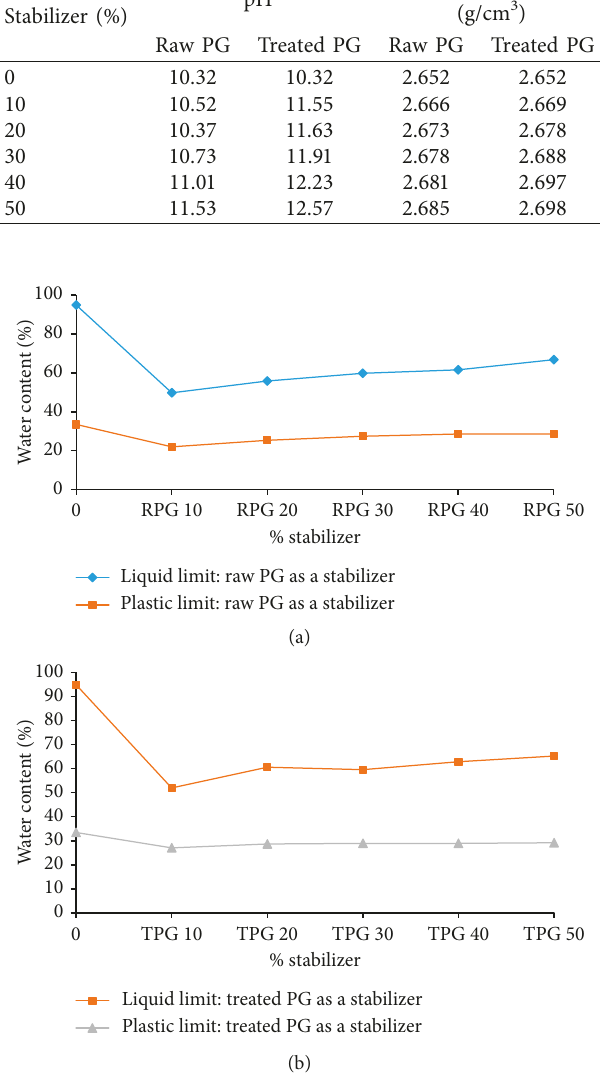
Figure 1: Liquid limit and plastic limits of soil samples that were stabilized by (a) raw PG-LFA and (b) treated PG-LFA-BOF.